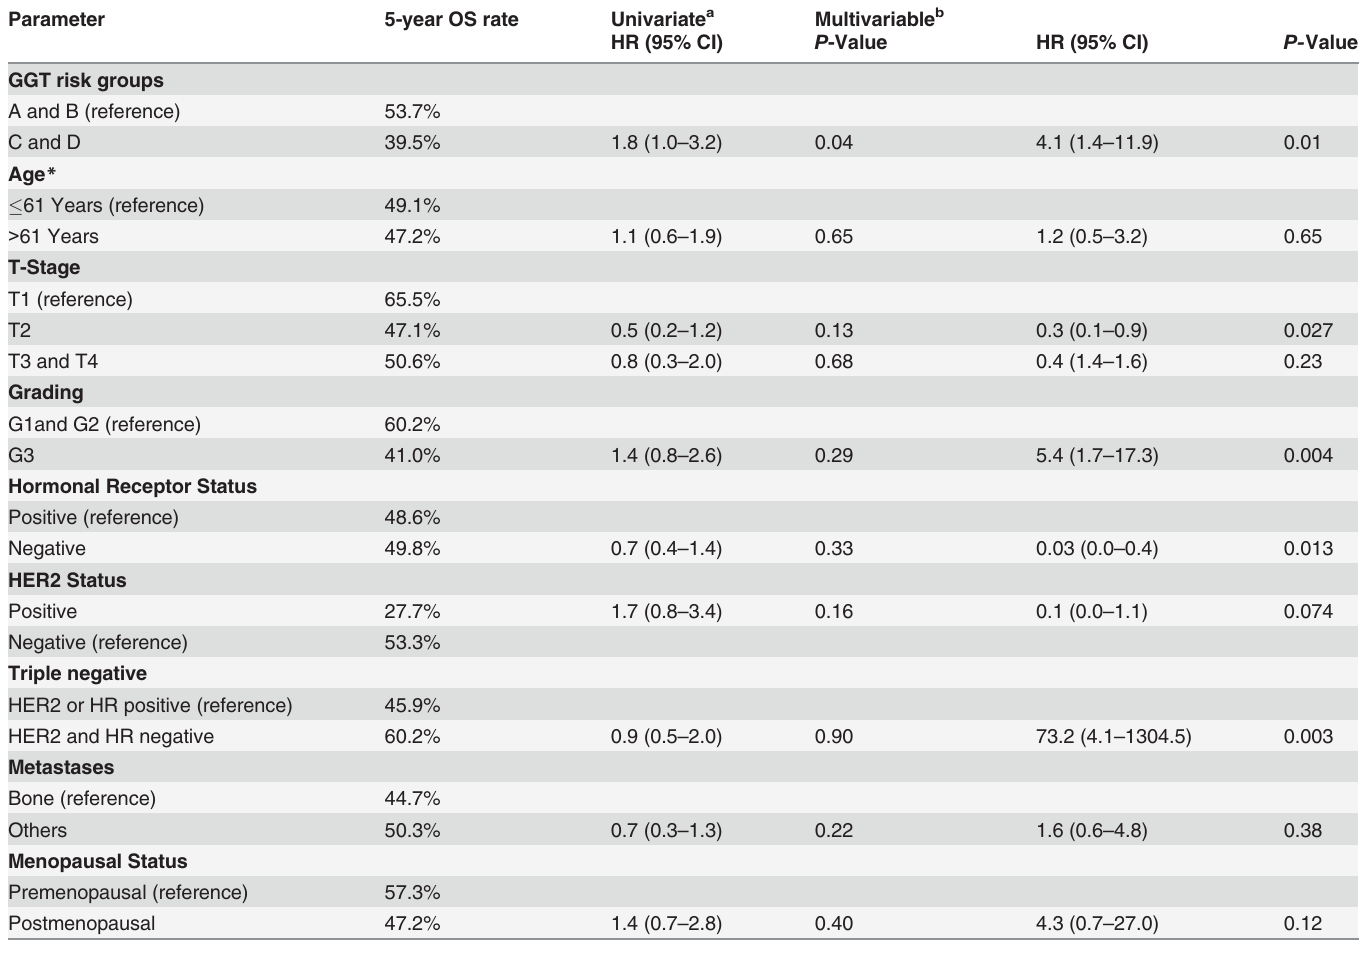
Table 3. Univariate and multivariable overall-survival